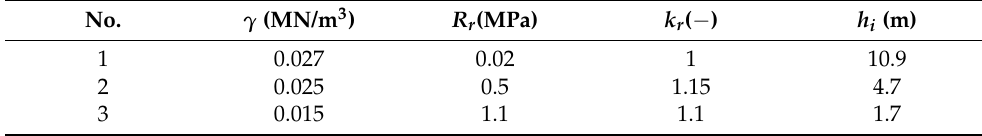
Table 1. Strength properties of the rocks constituting the rock